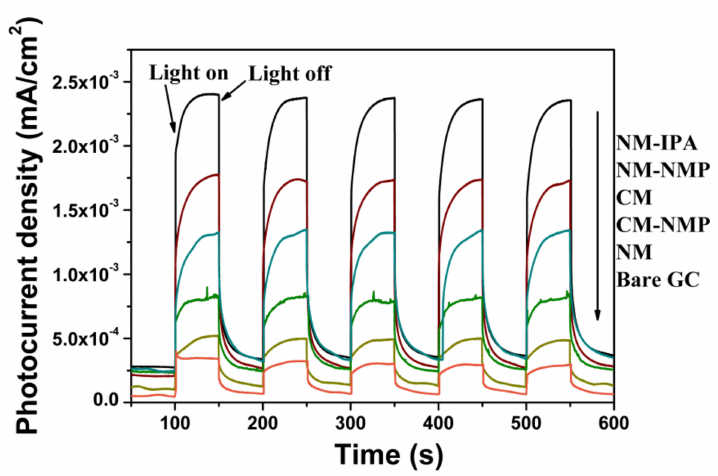
Figure 5. The transient on/off photocurrent responses vs. time plotted for NM-IPA, NM-NMP, CM-NMP, NM, CM, and bare GC in 0.01 M Na 2 SO 4 solution under visible-light.